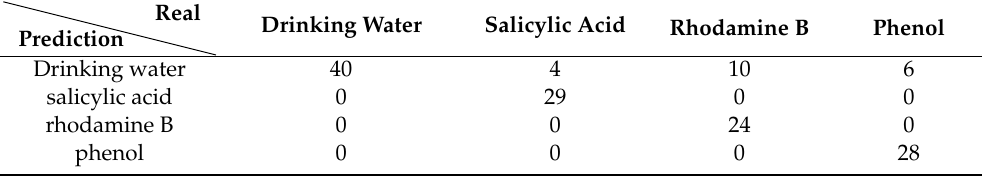
Table 2. Qualitative discrimination results of groups A and B without improved algorithm.